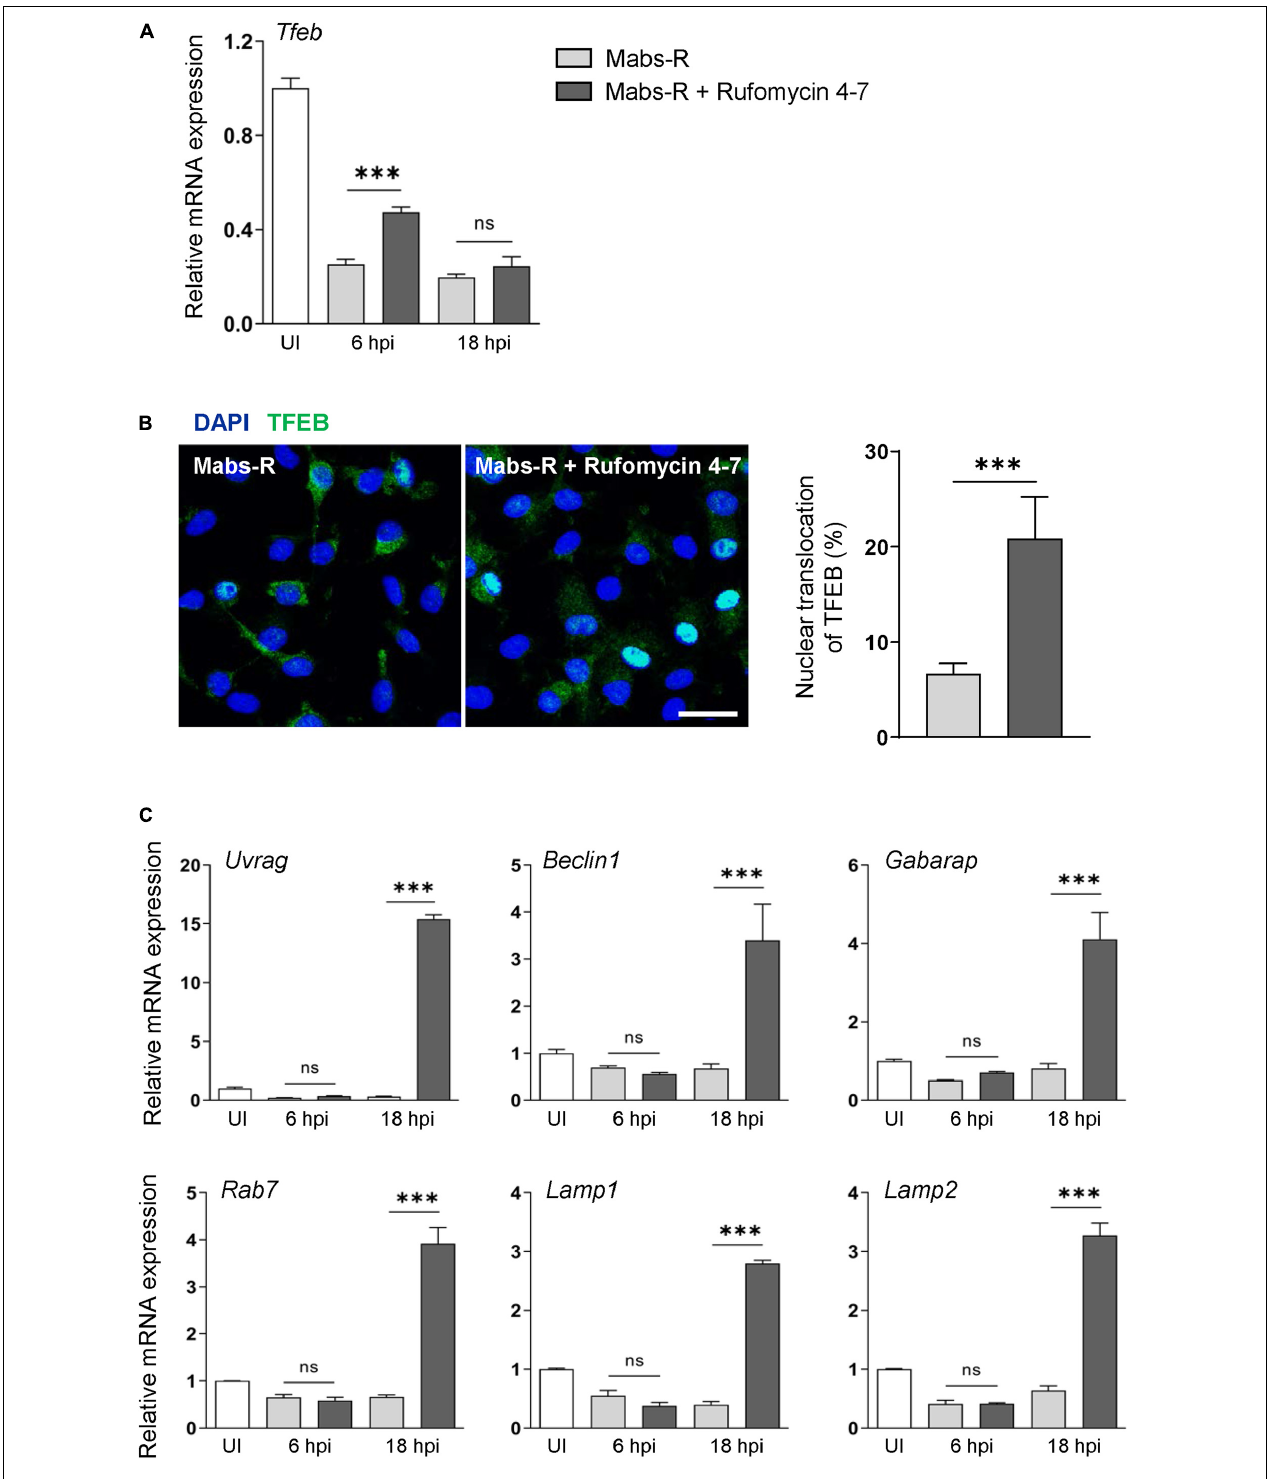
FIGURE 4 | Rufomycin 4–7 enhances TFEB-lysosomal gene expression during Mabs-R infection. BMDMs were infected with Mabs-R (MOI = 3) for 2 h and then incubated with sc or Rufomycin 4–7 (10 µ M) in the freshly changed media for the designated time. (A) The mRNA expression level of TFEB was determined by qRT-PCR. (B) At 12 hpi, the cells were fixed, permed, and stained with anti-TFEB antibodies (green) and DAPI (blue) to visualize fluorescent images using confocal microscopy (scale bar: 12.5 µ m). The cells with TFEB translocated into the nucleus was manually calculated from the confocal images ( n = 8 for each group; at least 80 cells per image). (C) Cells were lysed and total RNAs were extracted, followed by qRT-PCR analysis with primers of TFEB-downstream autophagic/lysosomal genes including Uvrag , Beclin1 , Gabarap , Rab7 , Lamp1 , and Lamp2. ∗∗∗ p < 0.001. Statistical analysis was determined with one-way ANOVA (A,C) or unpaired t -test (B) . Data are presented as means ± SD from at least three independent experiments performed in triplicate. ns, not significant; UI, uninfected; hpi, hours post-infection. Frontiers in Microbiology |